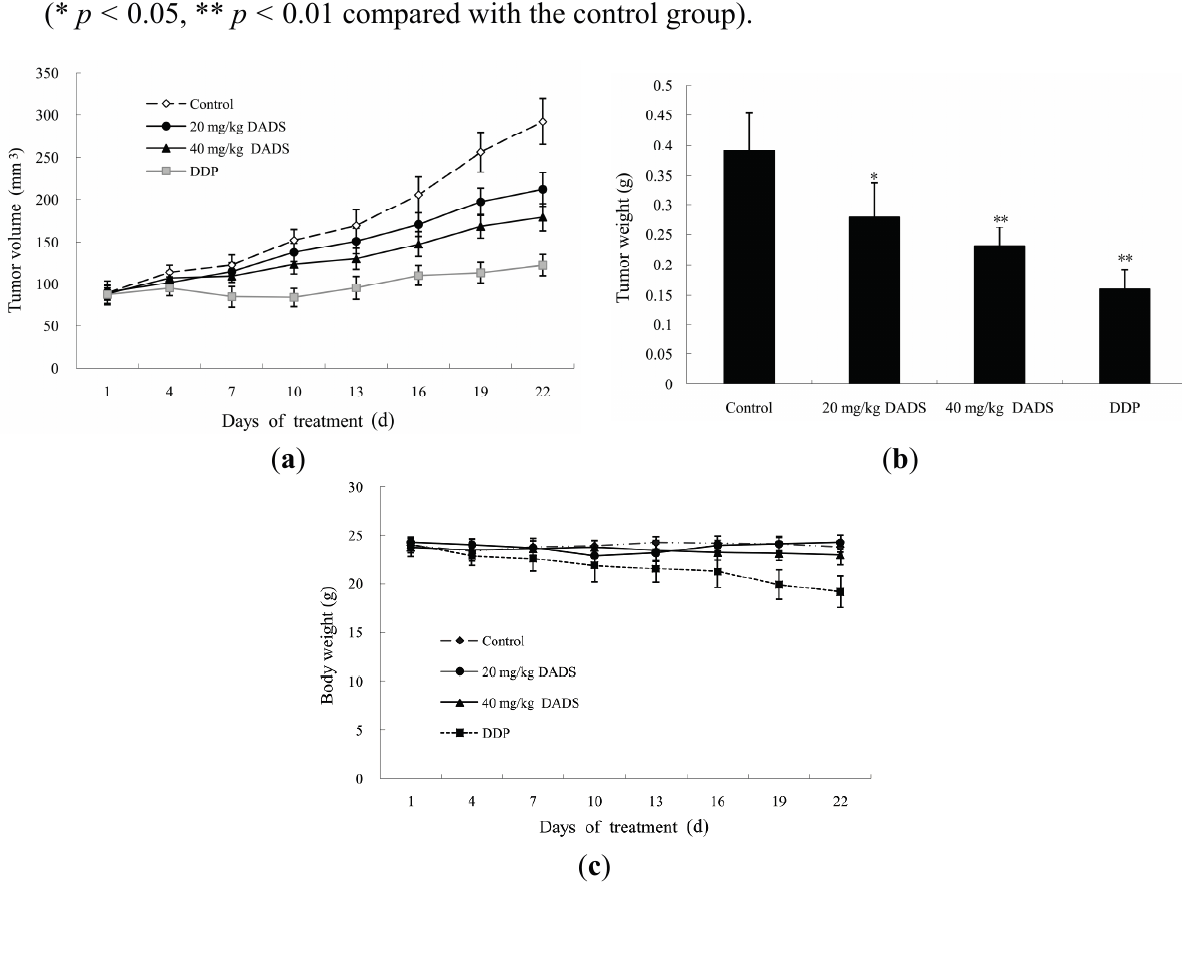
Figure 4. Effects of DADS on ECA109 xenograft tumor. Nude mice were implanted with ECA109 cells. After the xenograft tumors became palpable, intraperitoneal injections